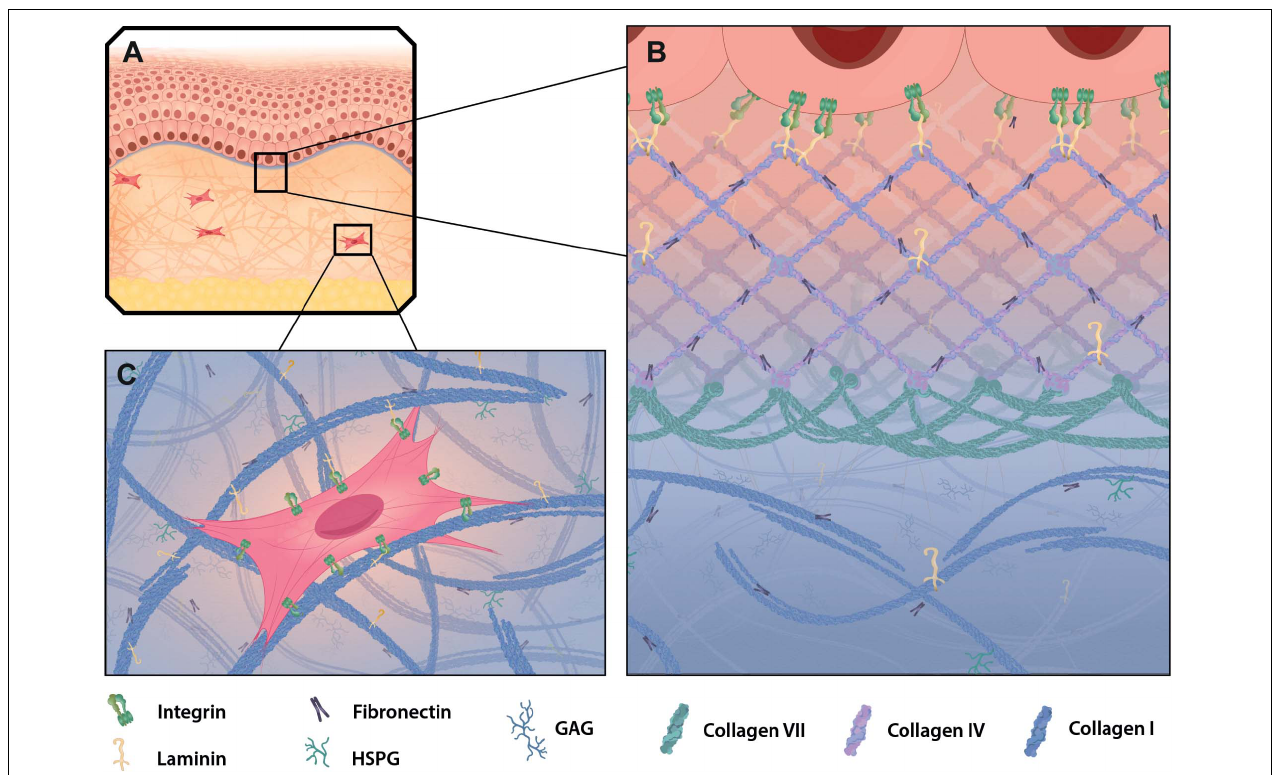
FIGURE 3 | ECM in healthy mammalian skin. (A) Skin is composed of the epidermis (top part), dermis (mid part) and adipose cell-rich hypodermis (lower part) and resembles a highly accessible model tissue to study epithelia, connective tissue and extracellular matrix (ECM) structures specific for those layers. The BM (purple) connects the epidermis to the dermis, which is comprised of interstitial matrix. (B) The dominant structural component in the BM is collagen type IV, which builds a meshwork with interspersed laminin and fibronectin. Together they build the basis for keratinocyte attachment via integrins. Collagen type VII reaches into the papillary dermis and stabilizes the dermal-epidermal junction. (C) In the dermis collagen type I and fibronectin build a fibrillary structure that allows cell adhesion and migration through the matrix. Shown is a fibroblast attaching to collagen and fibronectin via